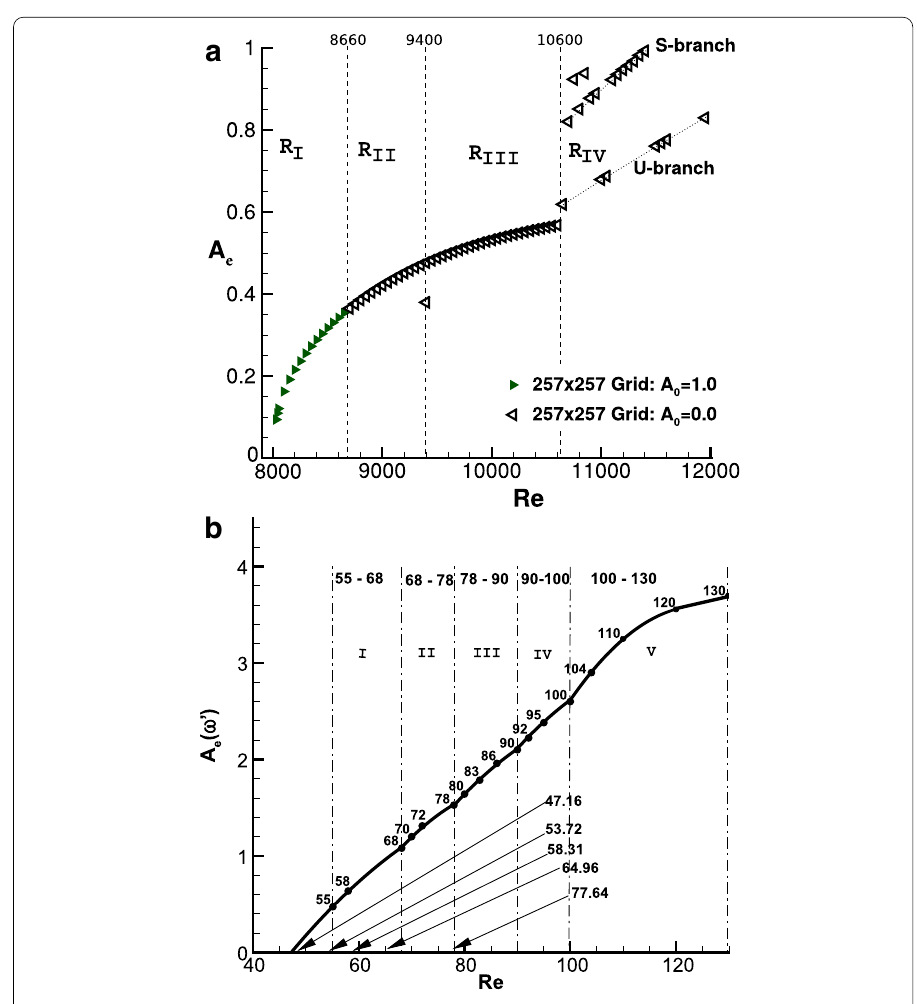
Fig. 3 Variation of equilibrium amplitude of disturbance vorticity with Re indicating the segments of Re with respect to bifurcation sequences for a flow in LDC and b for flow past a cylinder